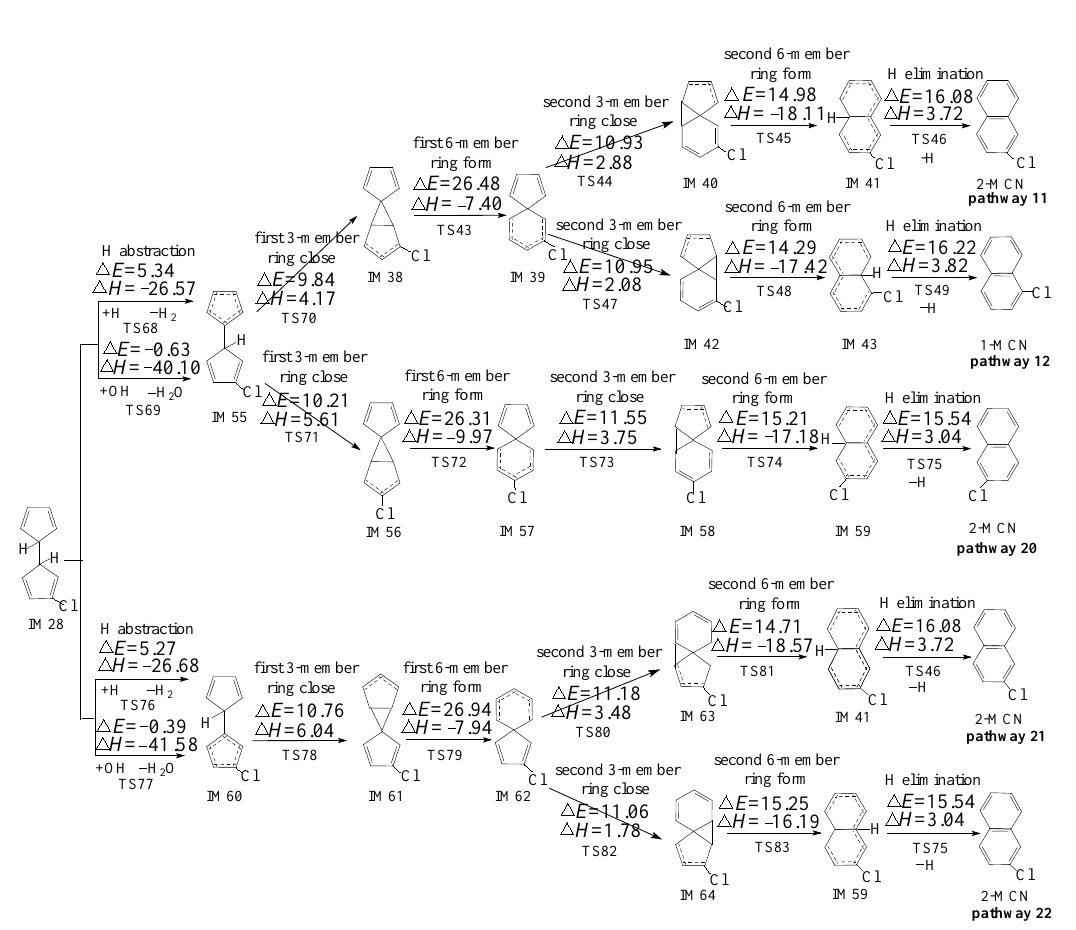
Figure 5. PCN formation routes embedded with the potential barriers Δ E and reaction heats Δ H from IM28.